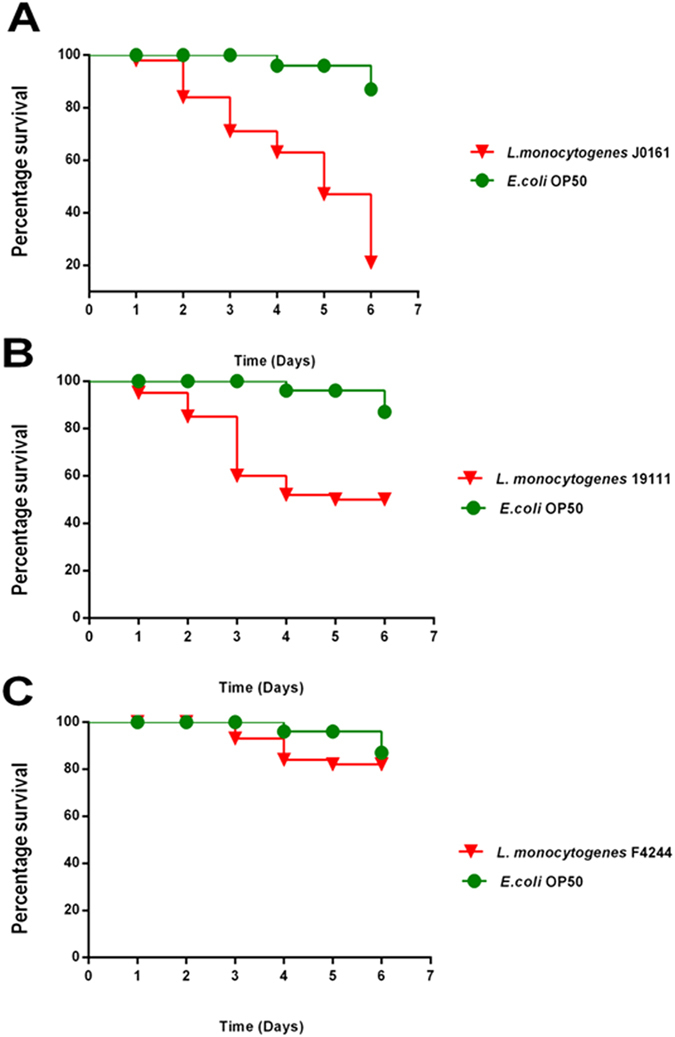
Killing of C. elegans by different strains of L. monocytogenes. Worms were grown on lawns of bacteria for 8 hours before washing and transferring to microtitre plate. (A) Worms fed E. coli OP50 or L. monocytogenes J016. (B) Worms fed E. coli OP50 or L. monocytogenes 19111. (C) Worms fed E. coli OP50 or L. monocytogenes F4244.